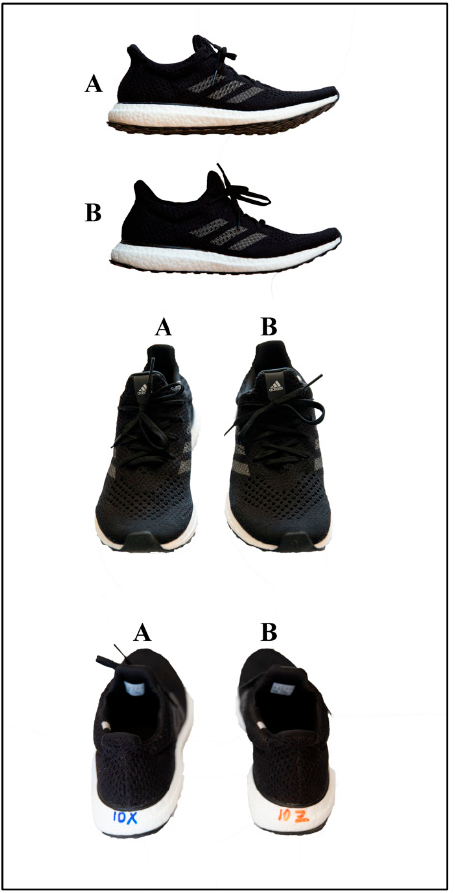
Figure 1. Image of the right grounding shoe ( A ) and traditional training shoe ( B ) for one of the elite athletes.